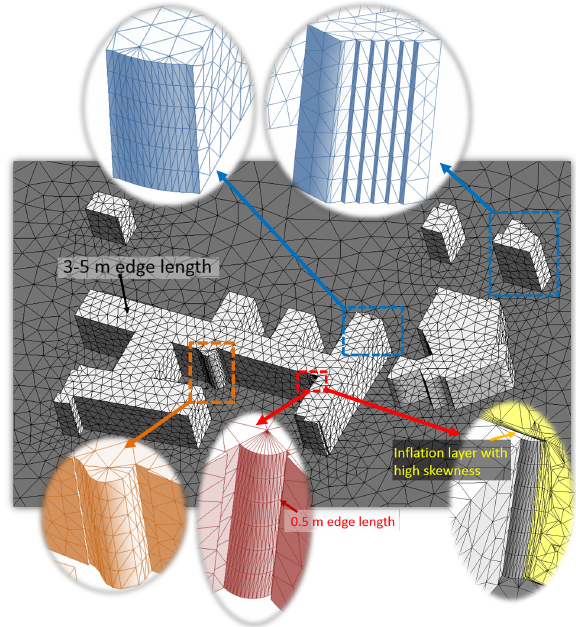
Figure 5. Original geometry: Boundary mesh of buildings. Suitable mesh with short edges (blue). Not suitable mesh due to high skewness of attached inflation layer (orange and red). Cross-section with inflation layer with to high skewness (yellow). The resulting boundary for the original geometry mesh is de- picted in figure 5. The surface mesh on the original geometry of building B (compare figure 5: orange and red regions of cylindri- cal parts) is valid. But, especially for the red region, the angles are quite small, which leads to the skewness beeing too high ( 0 . 96 ) inside of the mesh (compare figure 5: yellow region). During the CFD wind simulation in these regions the solver is not able to converge the turbulent